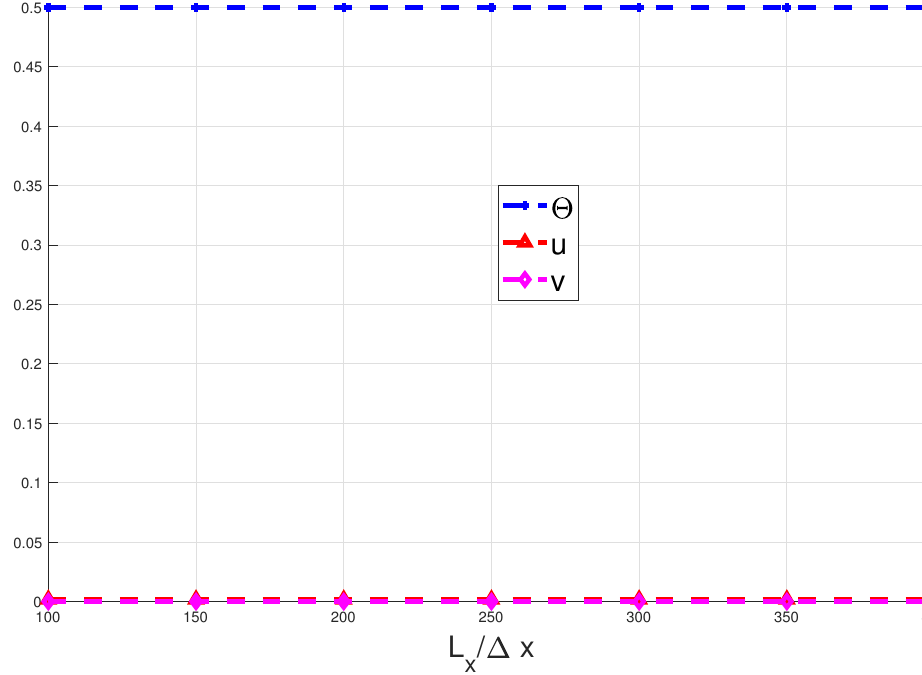
Figure 2. Illustration of mesh size independence at mid-point of the domain and t = 5.